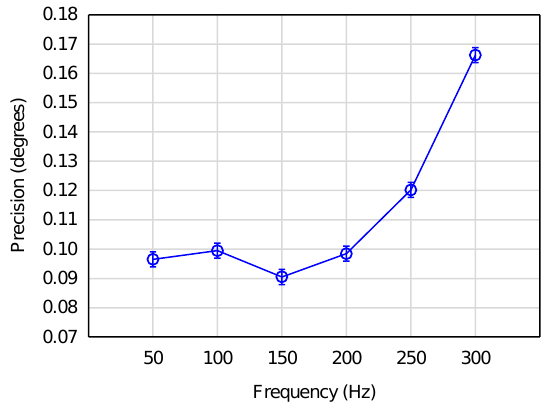
Figure 10. Precision against sampling frequency for artificial eyes